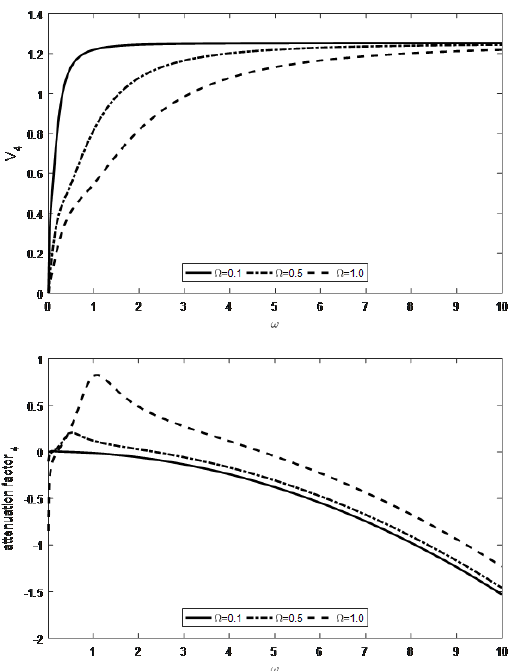
Figure 13: Velocity and attenuation factor for different values of ω and rotational